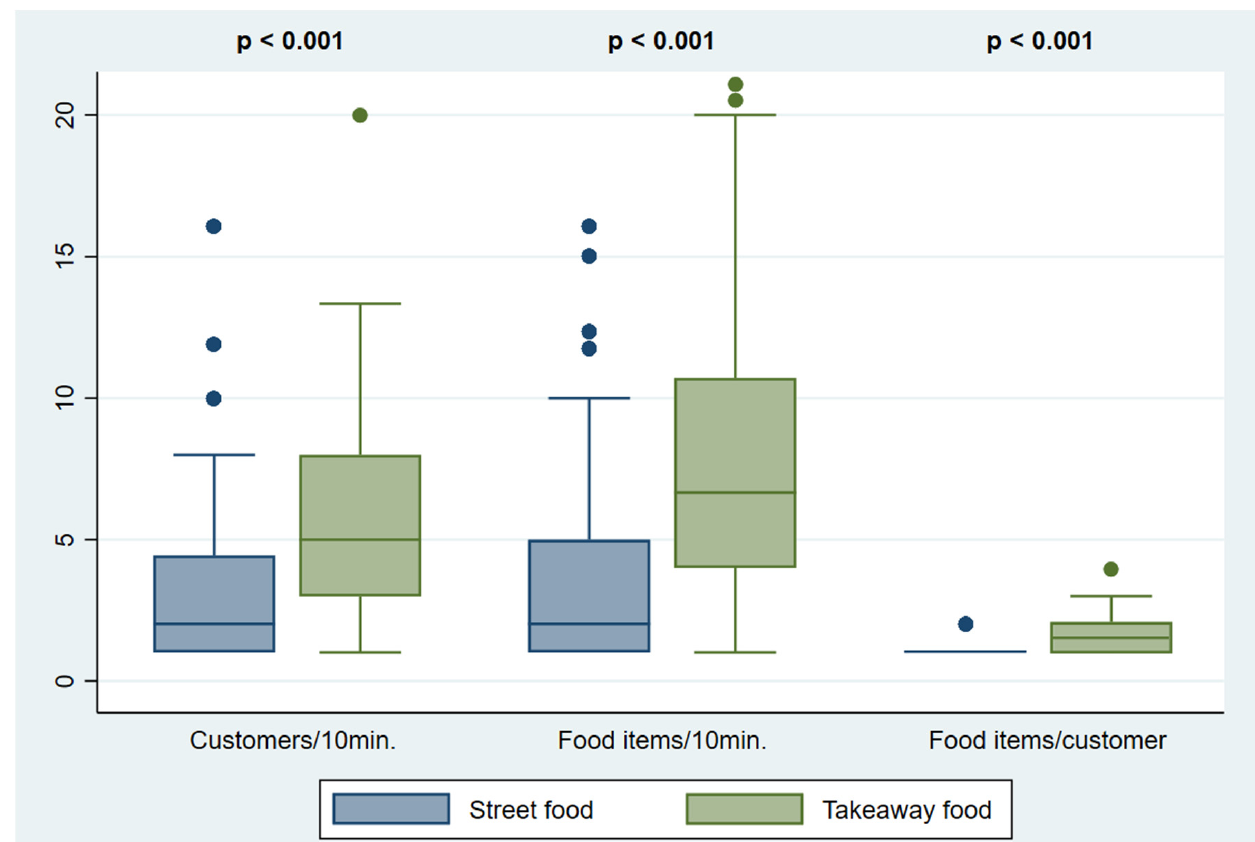
Figure 1. Customer influx, food items buying rate and number of food items purchased per customer, in the street food and takeaway food vending sites observed in Bosnia and Herzegovina.